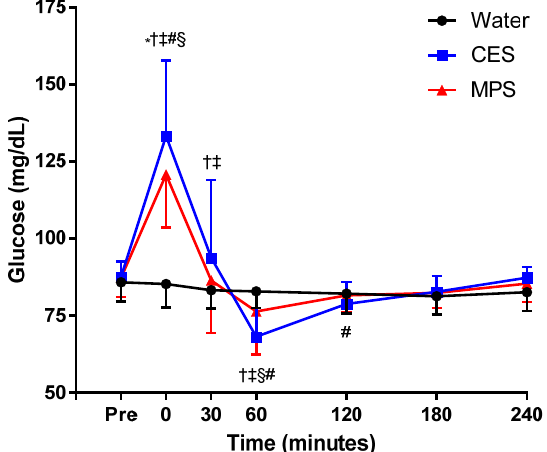
Figure 6. Plasma glucose concentration before and after consumption of water, a carbohydrate–electrolyte solution (CES), and a milk permeate-based solution (MPS). Glucose concentrations were significantly higher in CES and MPS compared to water immediately after and 30 min after ingestion of solutions. CES was higher than both MPS and water immediately after ingestion but lower at 60 min post-ingestion. Values are means ± SEM. Differences between beverages were assessed by two-way ANOVA. * p < 0.05 MPS compared to water; † p < 0.05 MPS compared to CES. ‡ p < 0.05 CES compared to water. § p < 0.05 MPS compared to pre. # p < 0.05 CES compared to pre. & p < 0.05 water compared to pre.